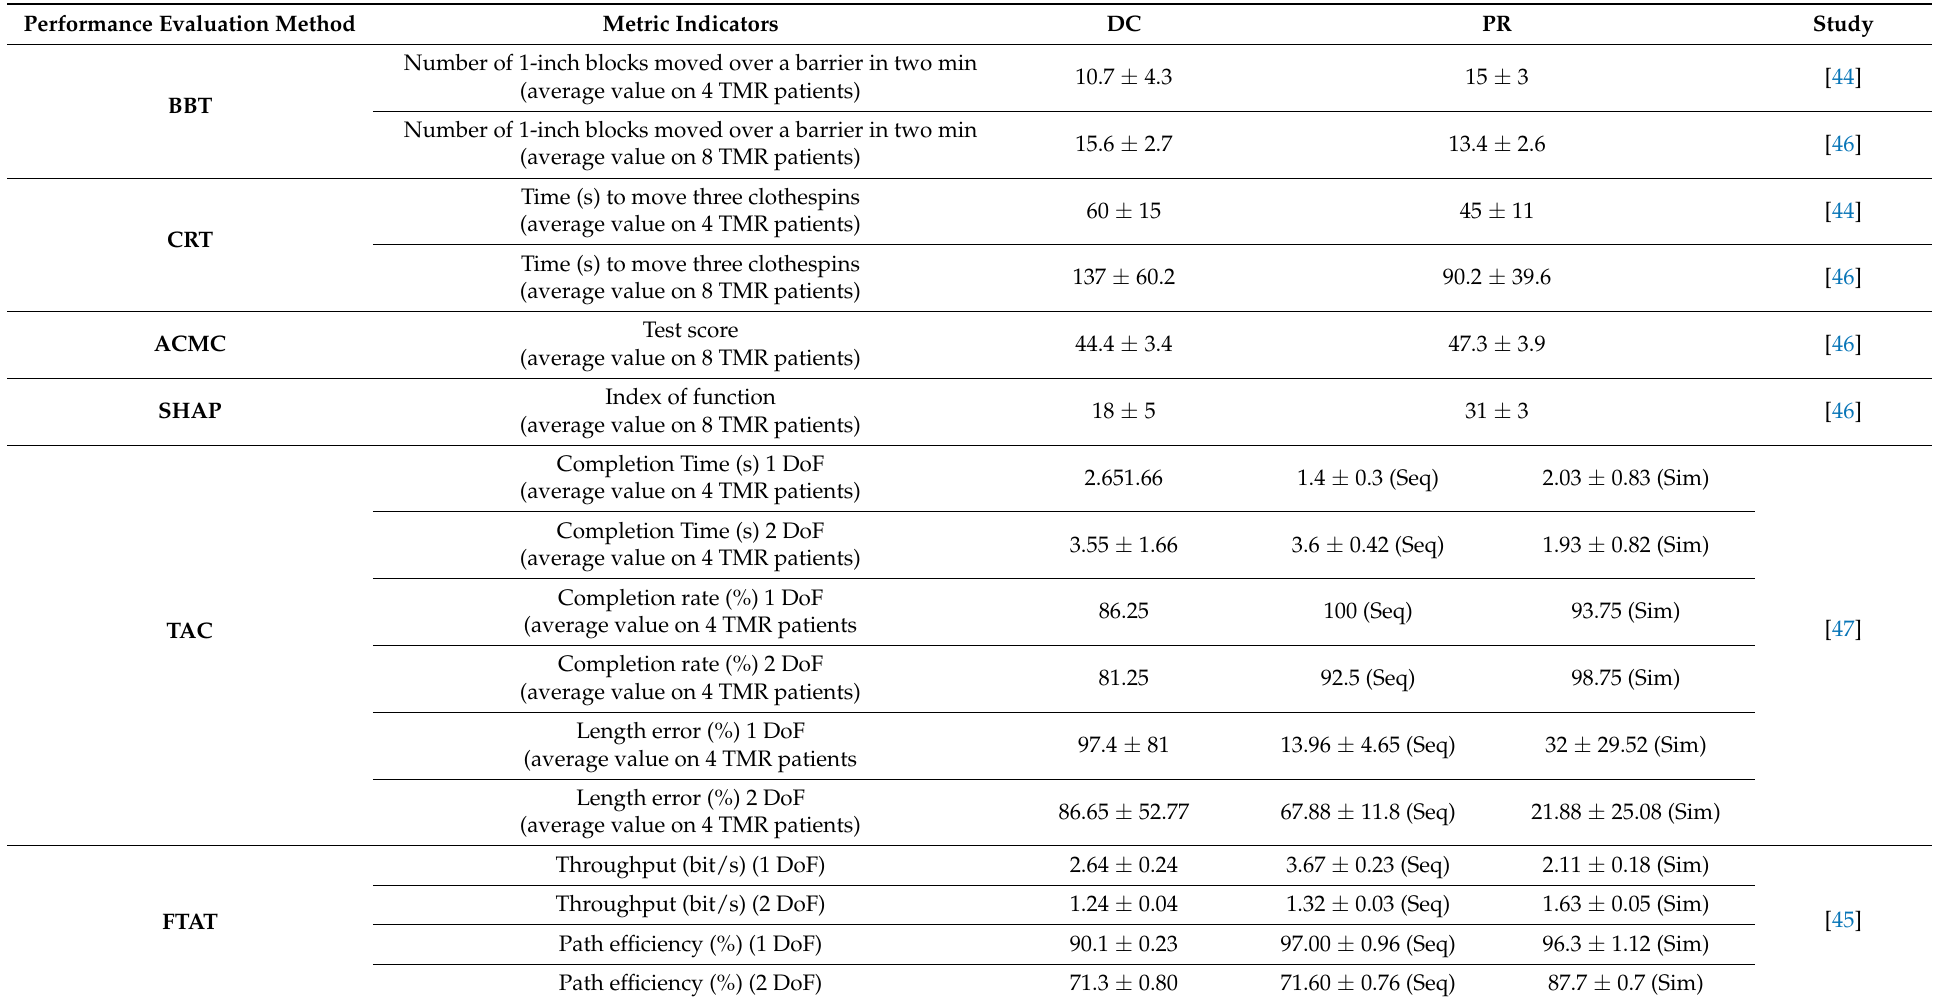
Table 3. Evaluation of the performance obtained with the DC and Pattern Recognition (PR) systems reported in the papers presented in Section